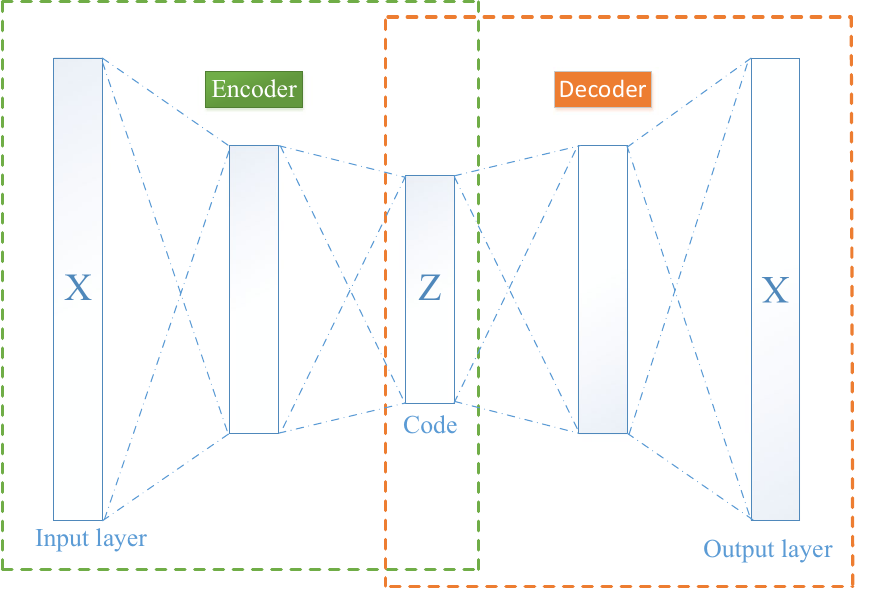
Figure 9. Network structure of the autoencoder used in this